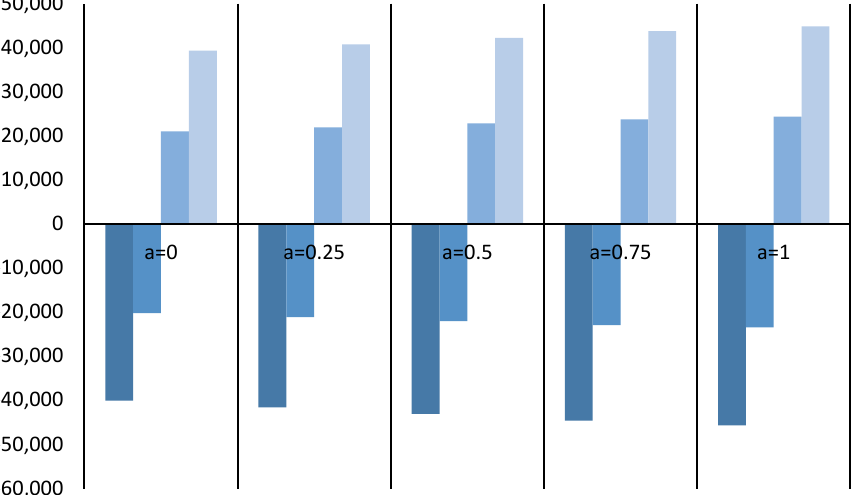
Figure 5. The average value of total profit with standard deviations.